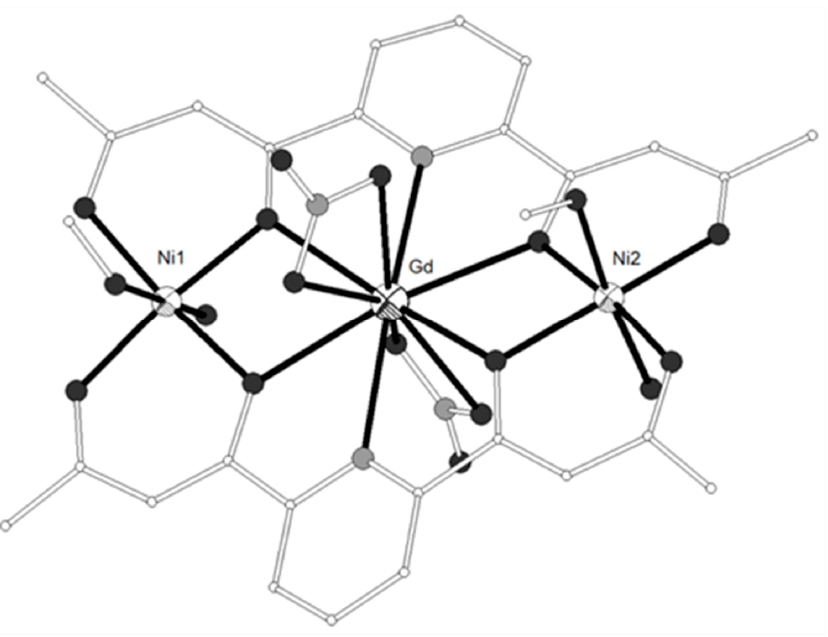
Figure 13. The molecular structure of the cation [(NiL 24 ) 2 Gd(NO 3 ) 2 (H 2 O) 2 (MeOH) 2 ] + in complex 118 . Color code as in Figure 2 [43].